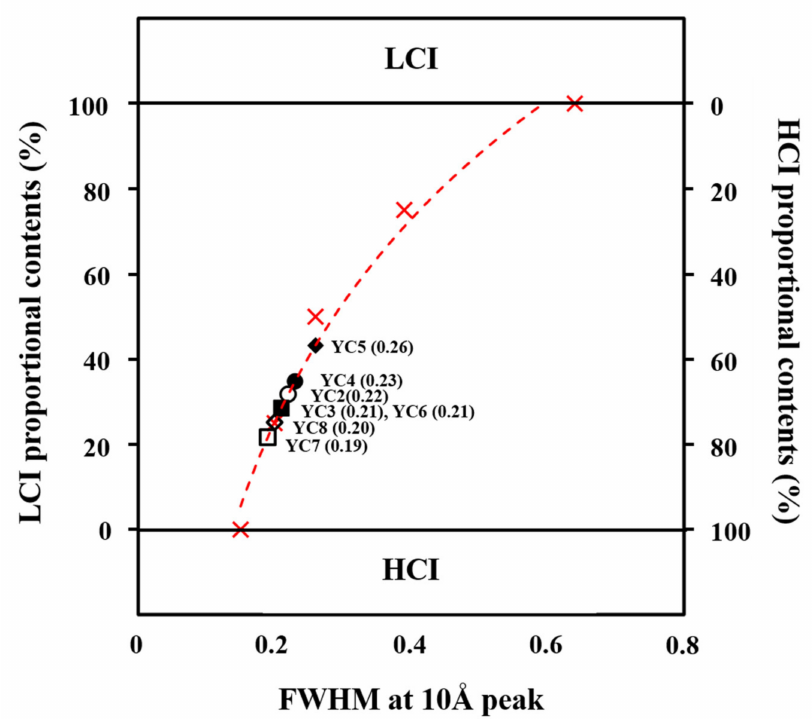
Figure 4. Calculated relative contents of low crystalline illite (LCI) and high crystalline illite (HCI) for the YC2–8 using full width at half maximum (FWHM) of 10 Å XRD peak. The YC1 was excluded for this analysis due to the existence of other expandable clay minerals. The dotted red line indicates the LCI and HCI reference line experimentally determined by the mixture of MI and CI samples with